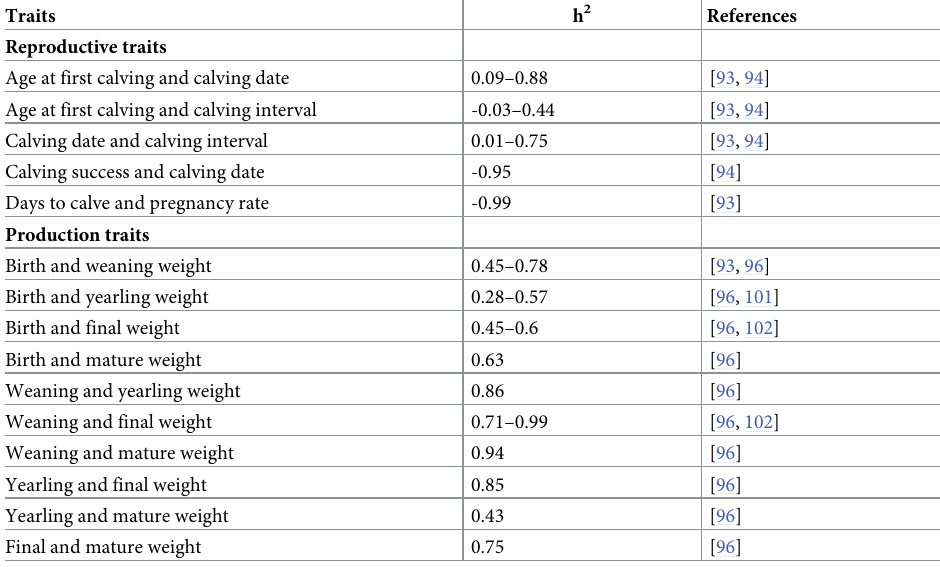
Table 8. Genetic correlations (rg) for specific fertility and production traits in tropical cattle breeds.